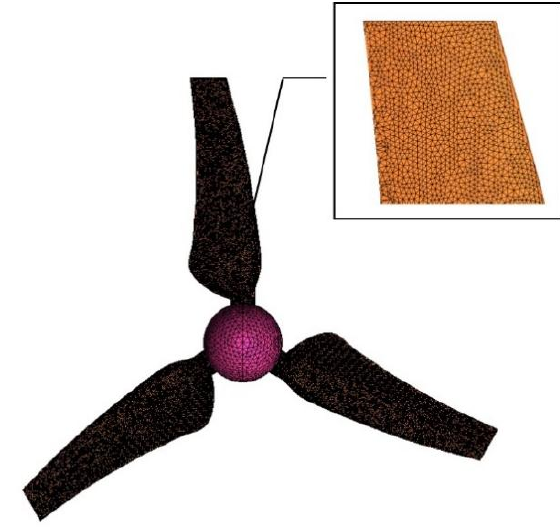
Figure 8. Grid division of turbine blade surface.